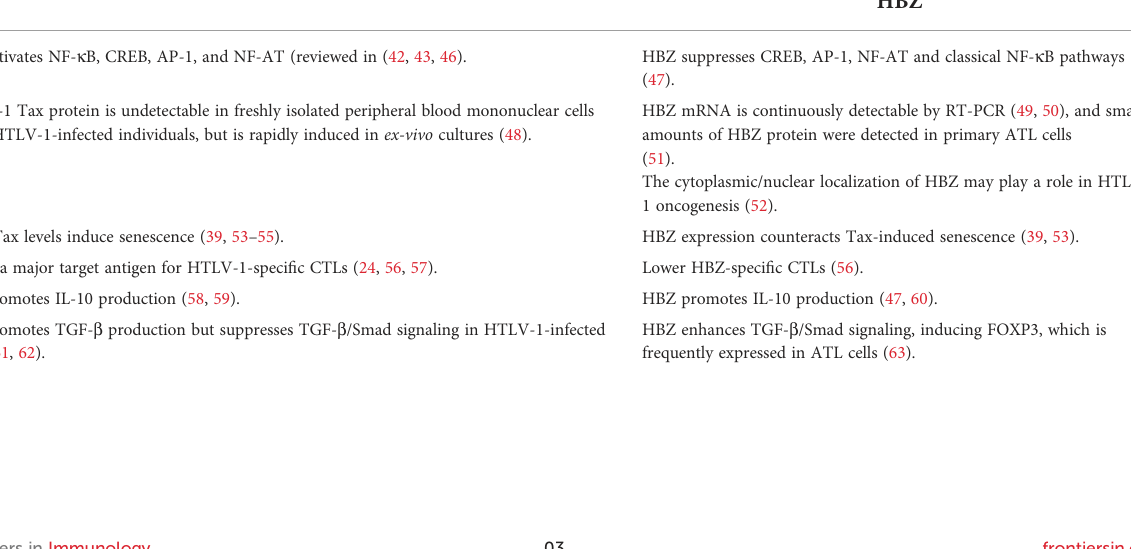
TABLE 1 Summary of some antagonistic cellular effects of Tax and